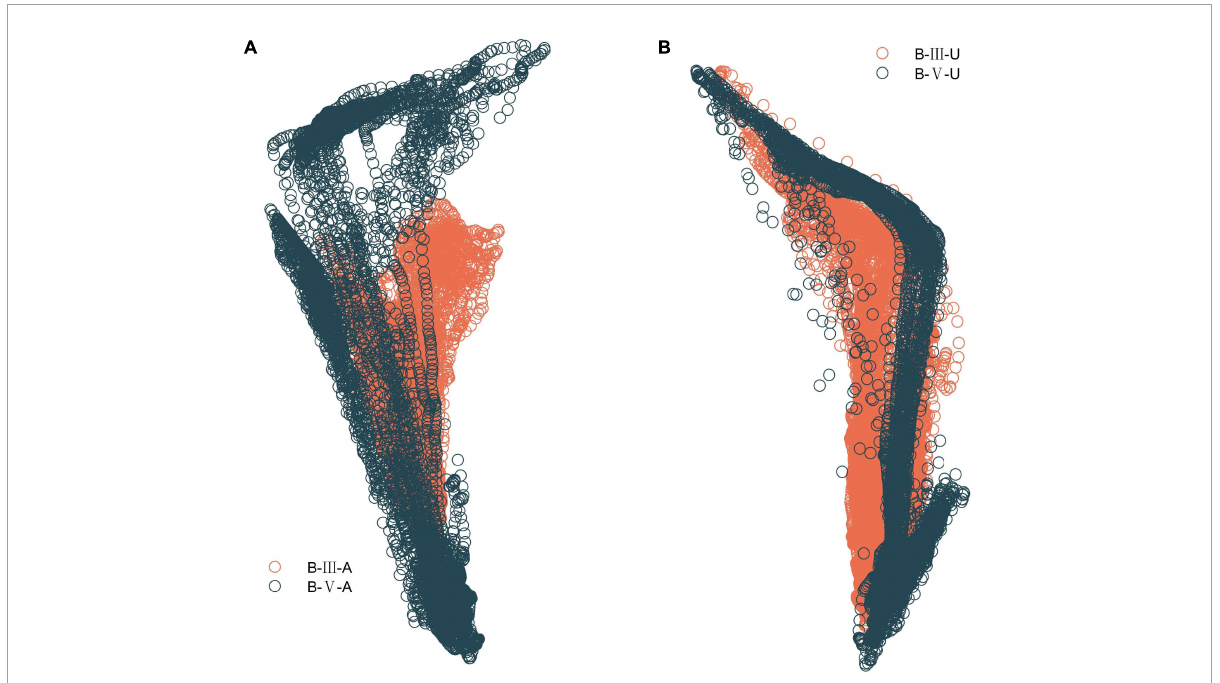
FIGURE10 Plantar CoP trajectory in B-III vs. B-V patients. (A) Comparison of CoP trajectory on the affected side. (B) Comparison of CoP trajectory on the unaffected